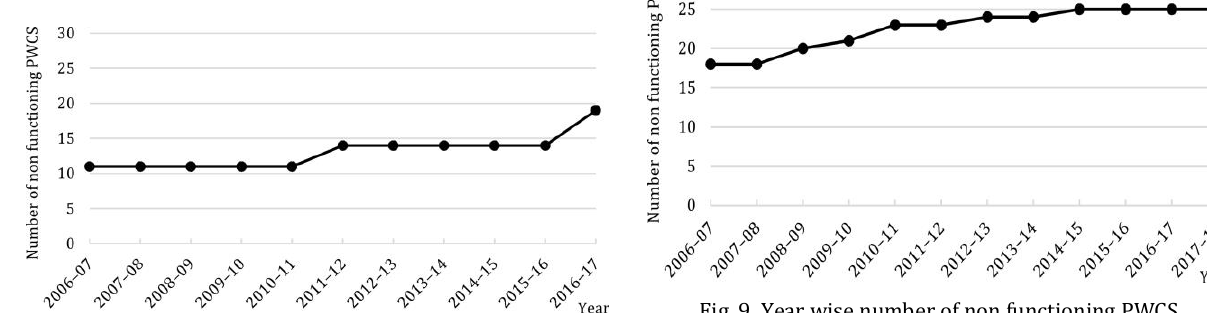
Table 1. Table showing amount of sale under co-operative fold (Source: Handloom Development Office, Chinsurah. 2017) Amount of sale under co-operative fold Year (million square metre) Chinsurah zone